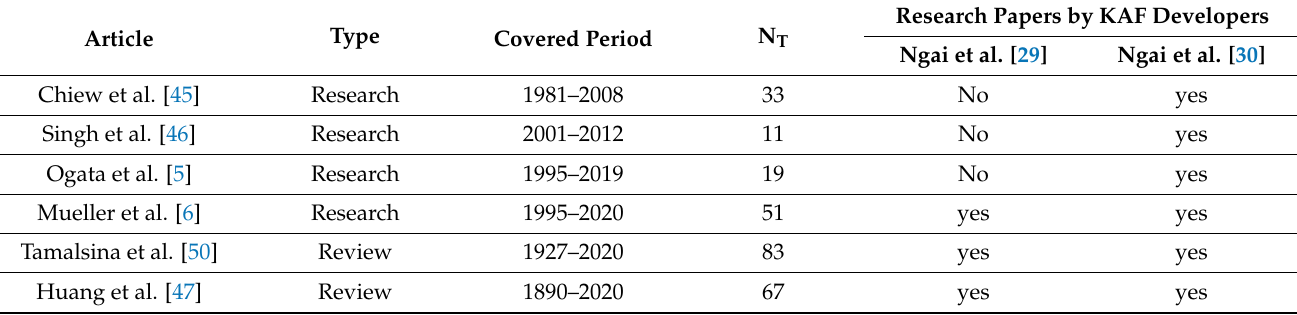
Table 2. Some characteristics of the eight peer-reviewed articles on KAF found and used in this study. The extent to which the two papers from KAF research groups [29,30] were considered by the six other studies is presented, and indicated by the answer, ‘Yes’ or ‘No’, to the question of whether or not they were cited in these studies. ‘N T ’ is the total number of cited references. It can be seen that the entire period of existence of the Fe 0 remediation technology (130 years) is covered. Thus, the present review can be seen as complete.